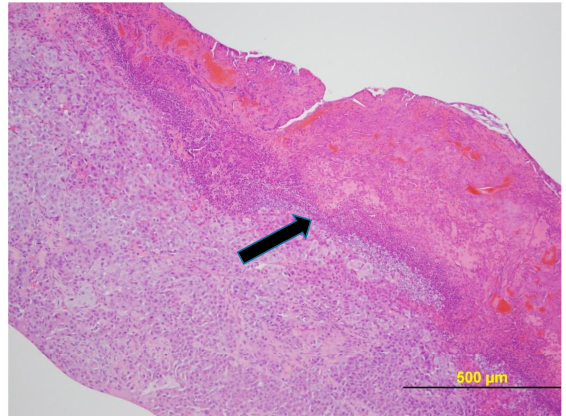
Figure 8. NCI-H460 human NSCLC xenograft (Mouse 4 with ulcerated 936 mm 3 tumor). H&E stain. The tumor had an ulcerated surface with karyorrhectic neutrophilic debris, eosinophilic debris, hemorrhage, keratin, and necrotic neoplastic cells within the site of ulceration (black arrow).